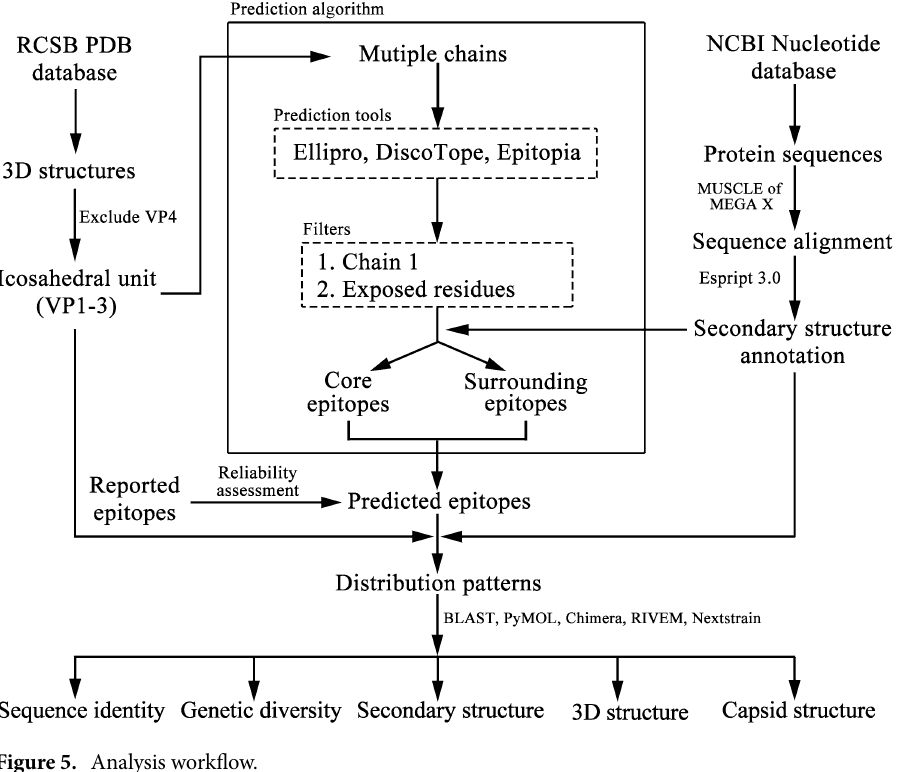
Figure 5. Analysis